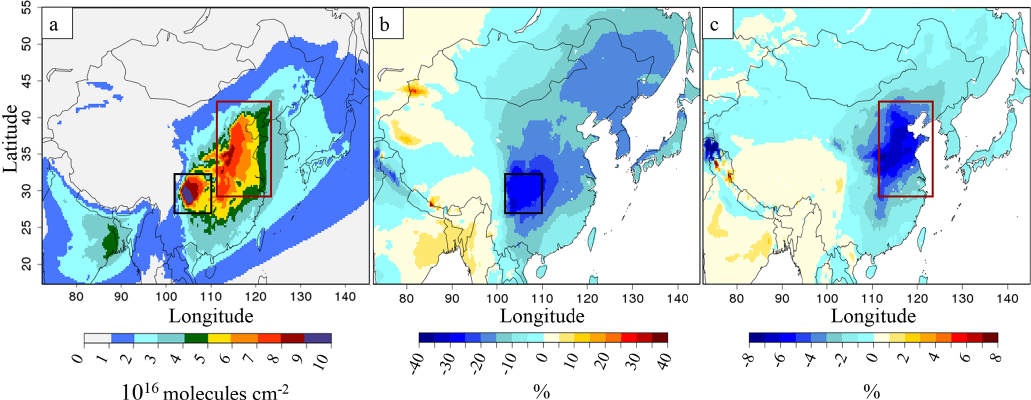
Figure 8. (a) Ammonium columns (moleculescm − 2 ) for the 2015A simulation, (b) relative differences of ammonium columns between the simulations from 2015B and 2015A, in %, and (c) additional relative differences of ammonium columns between the simulations from 2015C minus 2015B compared to 2015A, in %. The black rectangle is for the Sichuan Province and Chongqing municipality, and the red rectangle is for northern